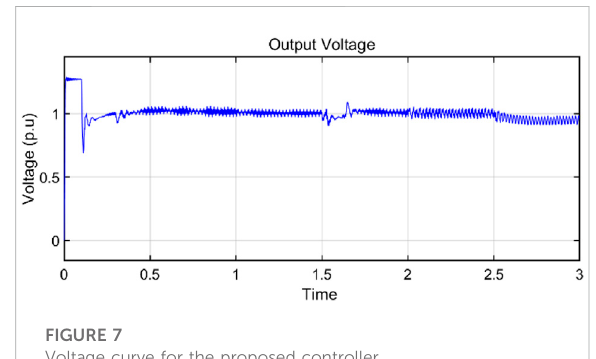
FIGURE 7 Voltage curve for the proposed